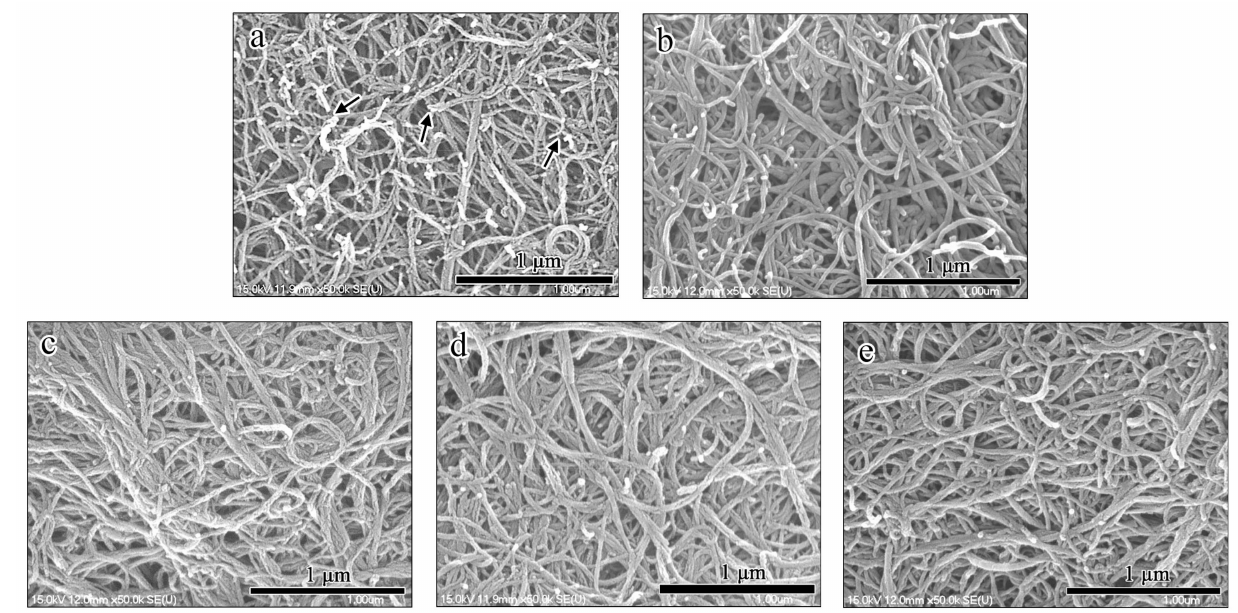
Figure 6. Microstructure of various specimens before adding BSA. ( a ) S–BP; ( b ) S–BP–EDC/NHS; ( c ) S–BP–PSS; ( d ) S–BP–SDS; ( e ) S–BP–TA. “Arrows” indicate some cutting surfaces of CNTs resulted from the carboxylation